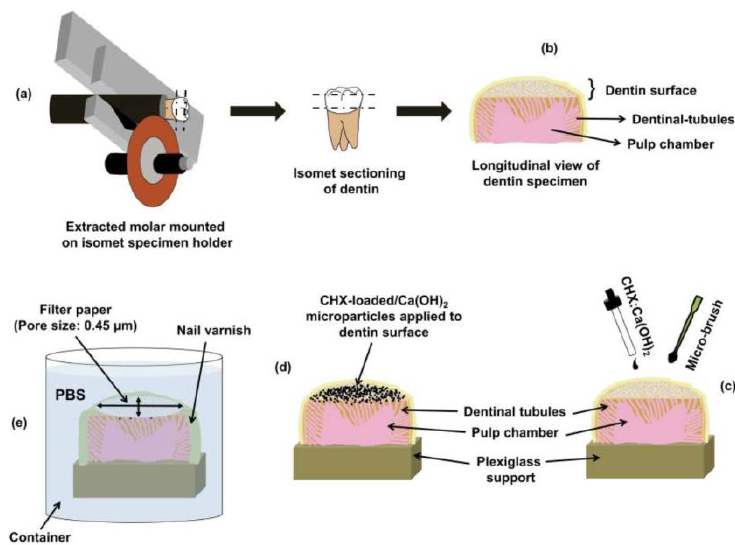
Figure 2. ( a ) Schematic sketch demonstrating the isomet sectioning procedure of extracted human molars for obtaining dentin-specimens used for microparticles delivery, the ex vivo drug-release experiments, and the confocal imaging for Live/Dead assay. The occlusal enamel surface was removed using low-speed diamond saw exposing the superficial-dentin approximately 3 mm beneath the DEJ (deep dentin). The dentin specimens were prepared by cutting parallel to the exposed dentin surface, about 0.5 mm above the CEJ, under running water. ( b ) After sectioning, the dentin specimens were wet-ground using 600 through 4000 grit-size silicon-carbide papers. The prepared dentin- surfaces were cleaned ultrasonically for 10 min and rinsed with distilled water. ( c ) Representative sketch showing the procedure of treatment of the prepared dentin-surface with 30 μL of microparticles suspended in distilled water (at the working ratio of 1/1 ( wt/v )), applied drop-by-drop for 60 s followed by gentle spreading on the surface by micro-brush for 5 s. Following application, the ( d ) The CHX-loaded/Ca(OH) 2 microparticles attached to the exposed dentin-surface following